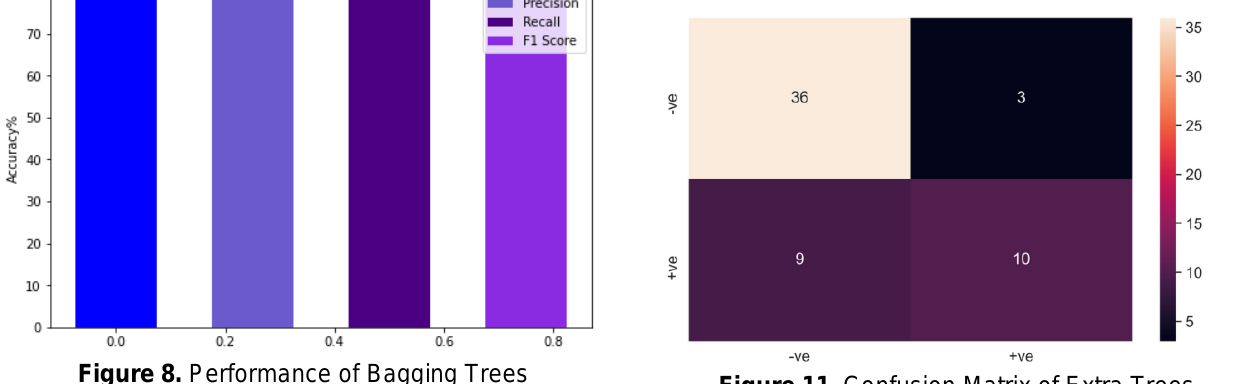
Figure 11. Confusion Matrix of Extra Trees